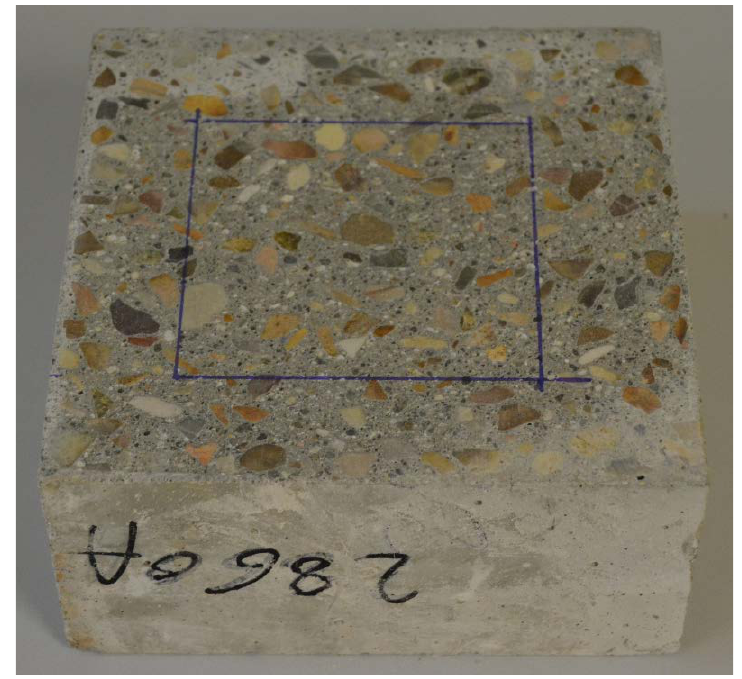
Figure 2. Surface of analysis drawn on the polished surfaces of a cubic sample.